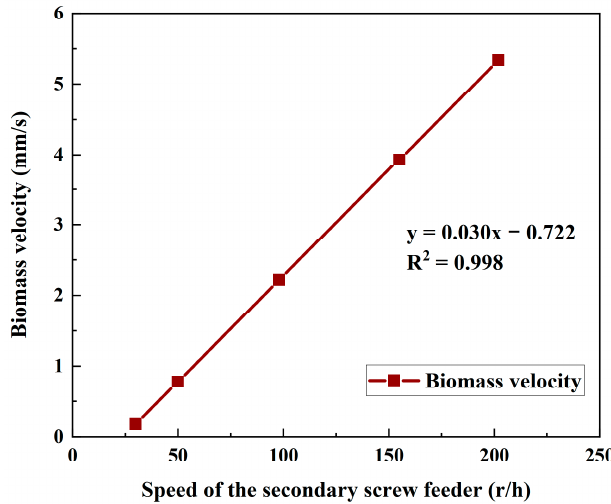
Figure 8. The relationship between biomass velocity and speed of the secondary screw feeder.